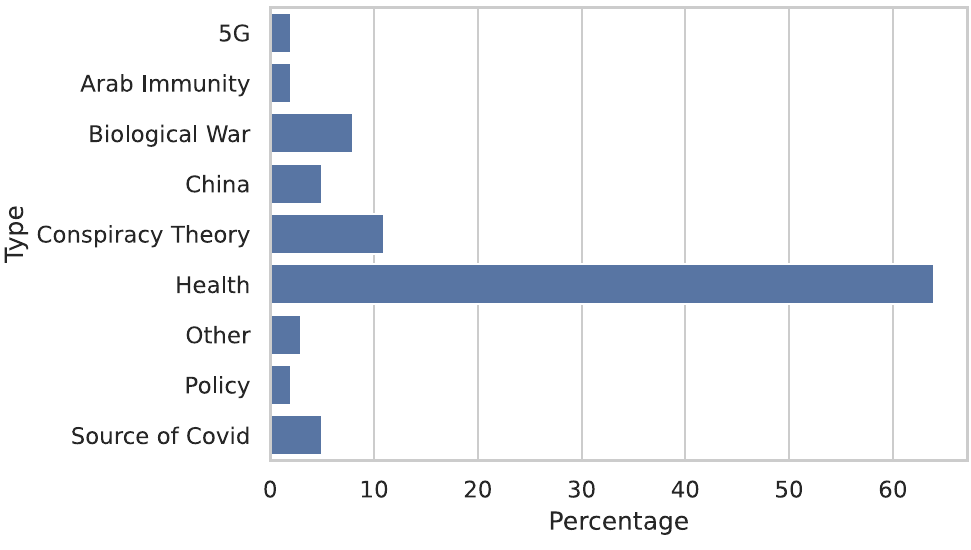
Figure 6. Types of reported